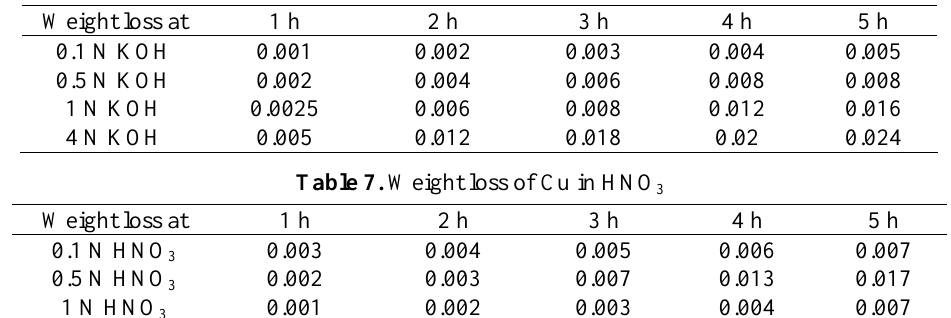
Table 6. Weight loss of Fe in KOH